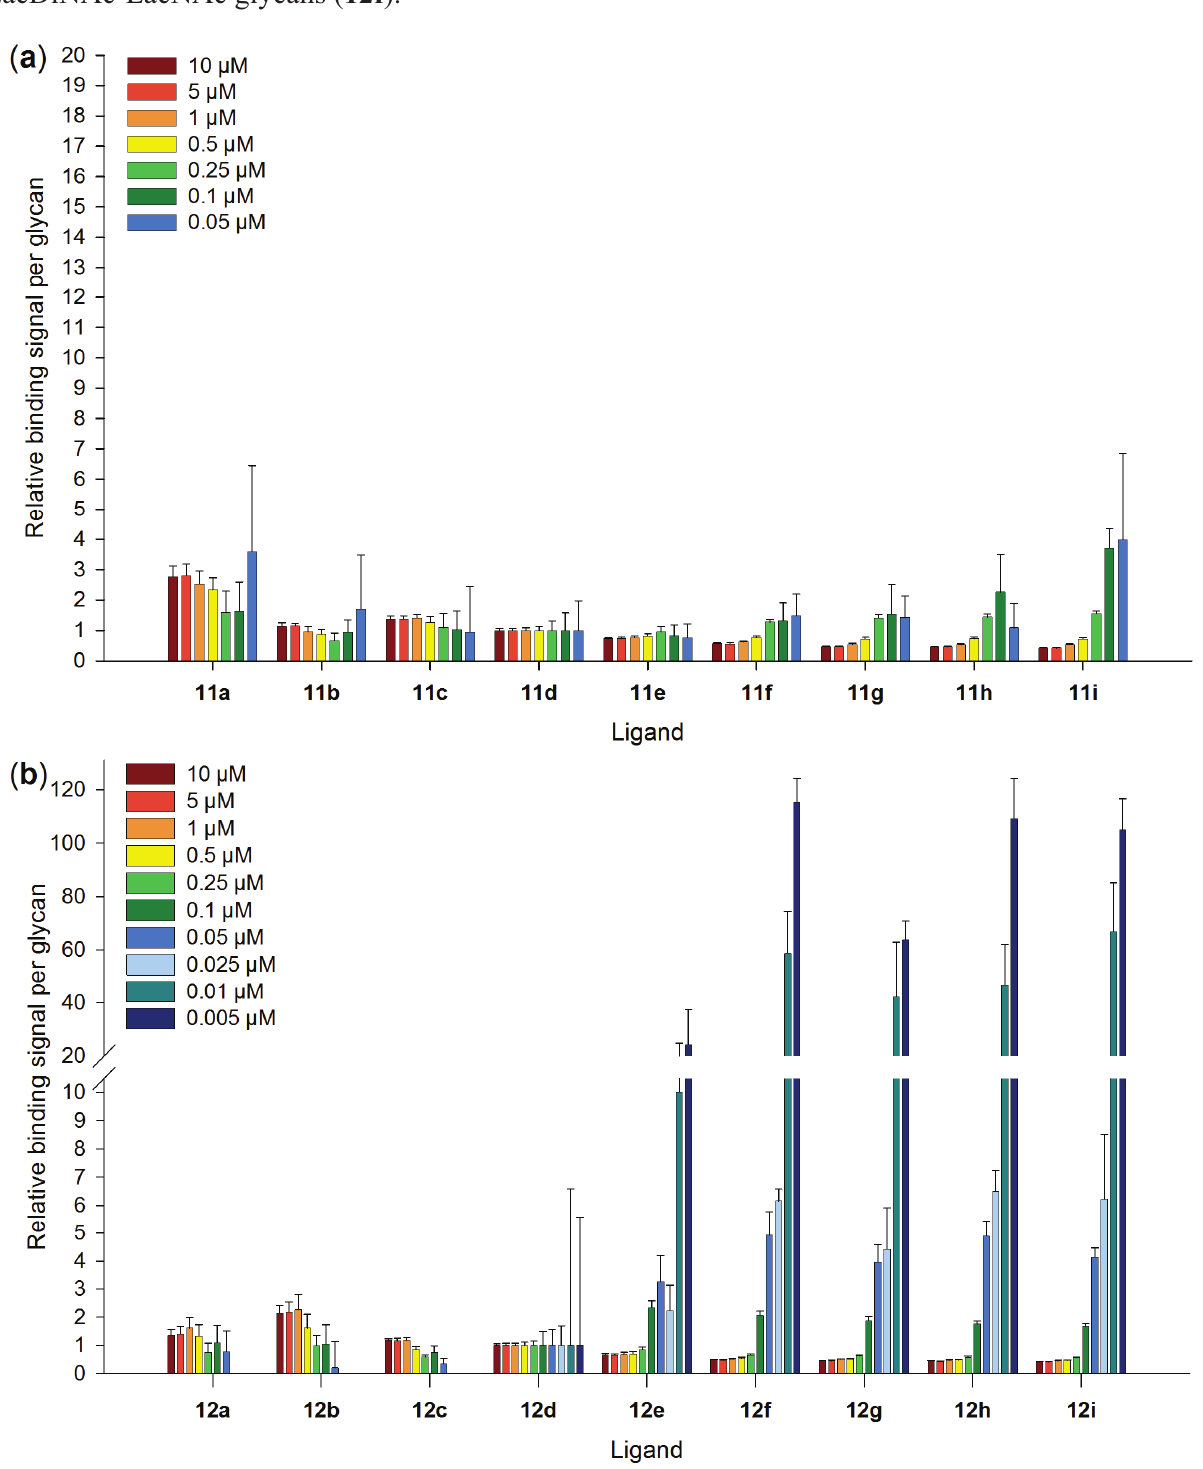
Figure 5. Binding signals of human galectin-3 in relation to one binding site for BSA based neo-glycoproteins. Relative signals of galectin-3 binding to neo-glycoproteins with ( a ) LacNAc-LacNAc and ( b ) LacDiNAc-LacNAc at galectin-3 concentration ranging from 0.005–10 μM are shown. Values of binding enhancement result from binding signals per glycan in relation to the galectin-3 binding per glycan for 11d and 12d ,